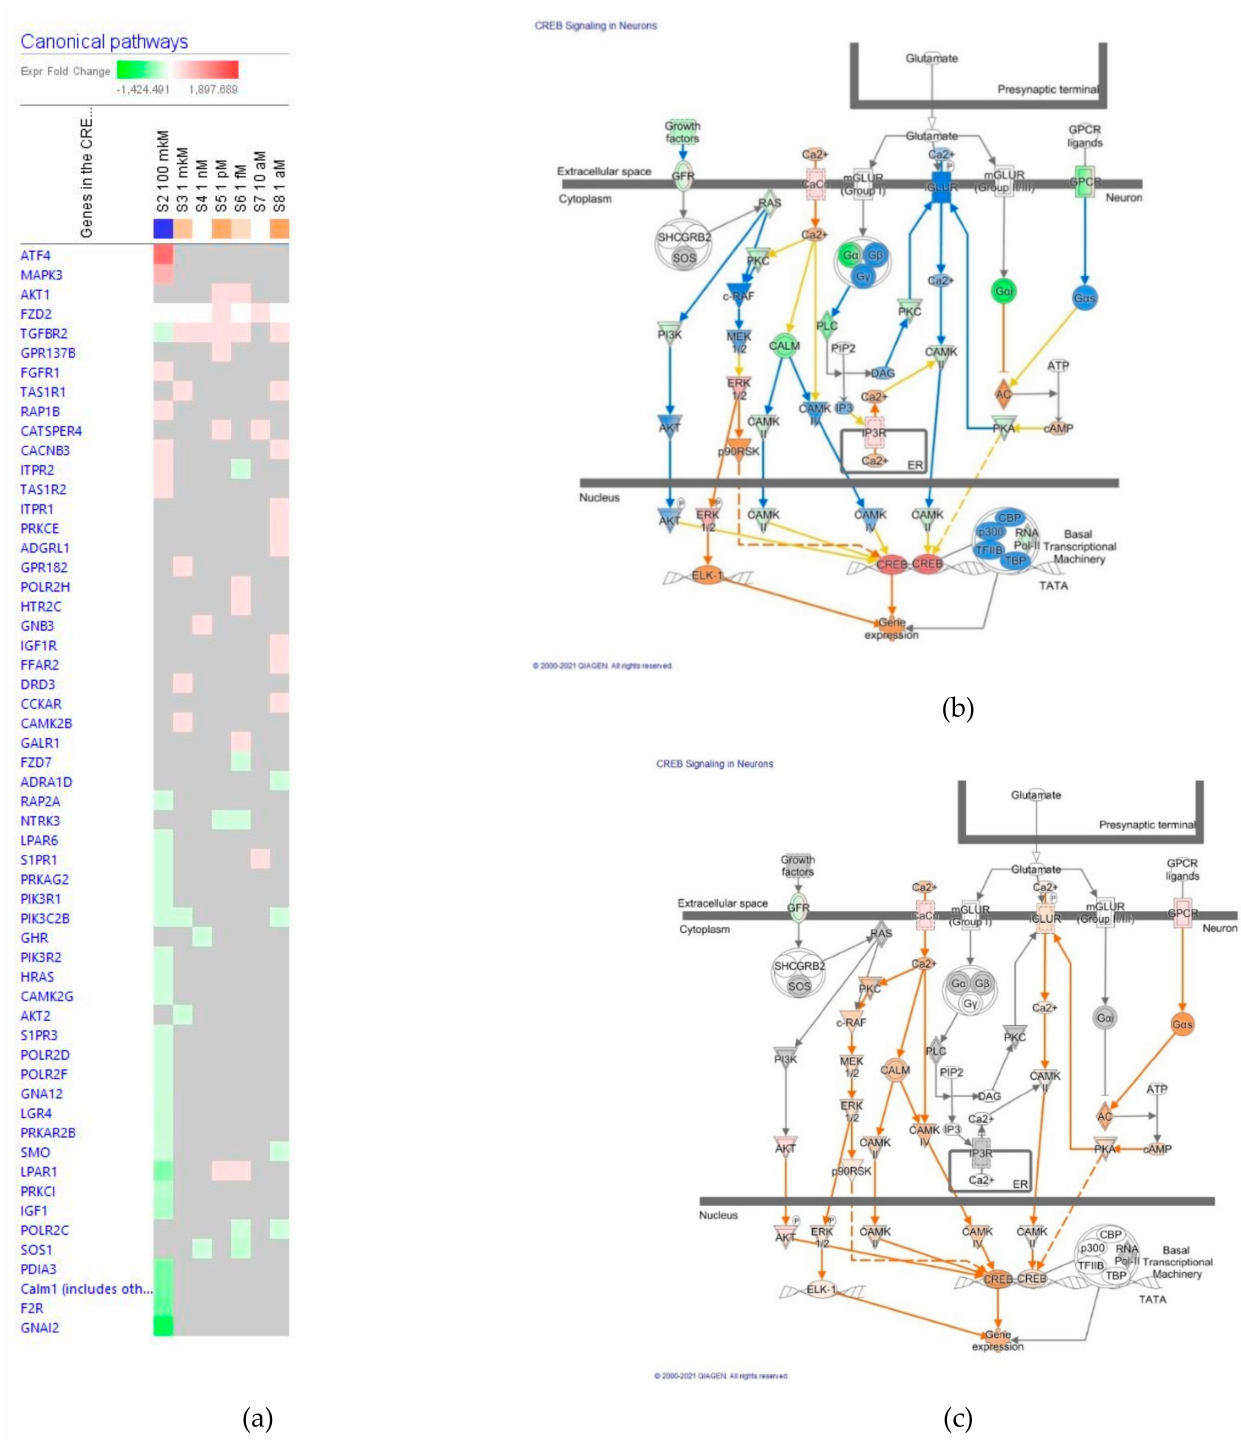
Figure 7. Effect of Rg5 on CREB signaling pathway: ( a ) Heatmap of gene expressions (in fold changes compared to control, red, upregulation and green, downregulation), after exposure with ginsenoside Rg5 at different concentrations; the 100 µ M signature is shown in the leftmost column as solid red or green squares indicating genes that are upregulated or downregulated, respectively; color intensity indicates the actual log-fold changes; ( b ) Rg5 at a concentration of 100 µ M— predicted inhibition (blue) and activation (brown); ( c ) Rg5 at a concentration of 1 µ M—predicted inhibition (blue) and activation